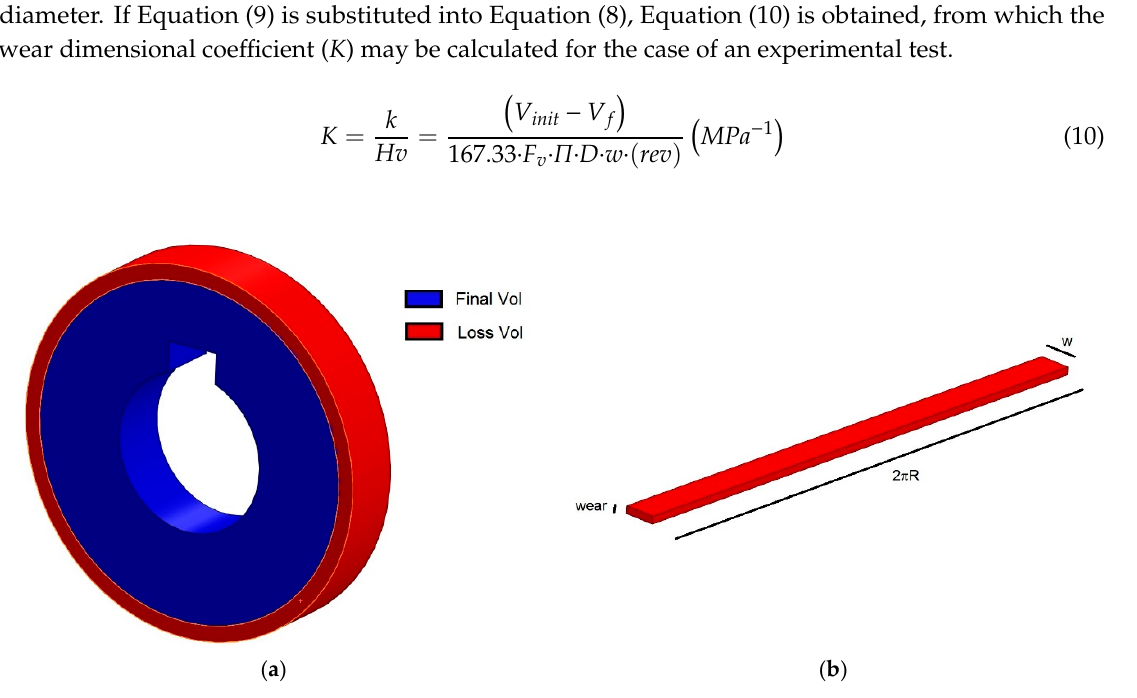
Figure 11. Disk after the wear experimental test ( a ) and final volume loss ( b ).